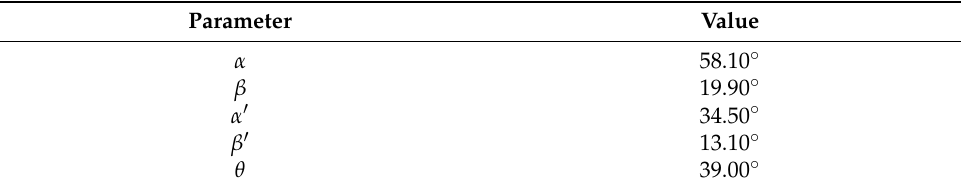
Table 3. Fixed parameters in Equation (18).